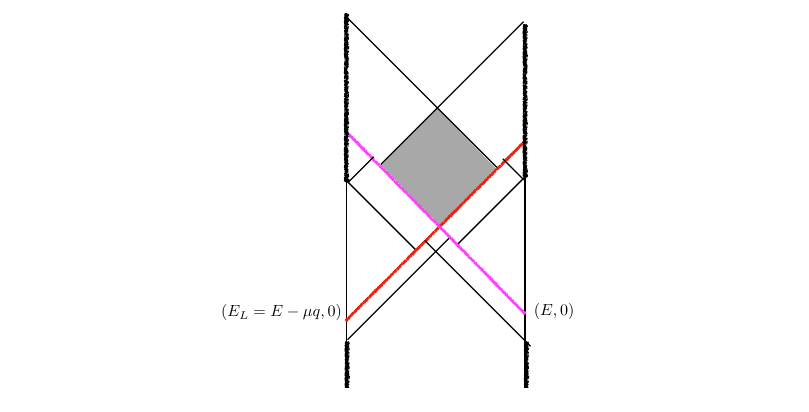
Figure 7 . Collision between two neutral shells with different energies. We are interested in the volume of the region to the future of both shocks, up to the inner horizon (shaded in